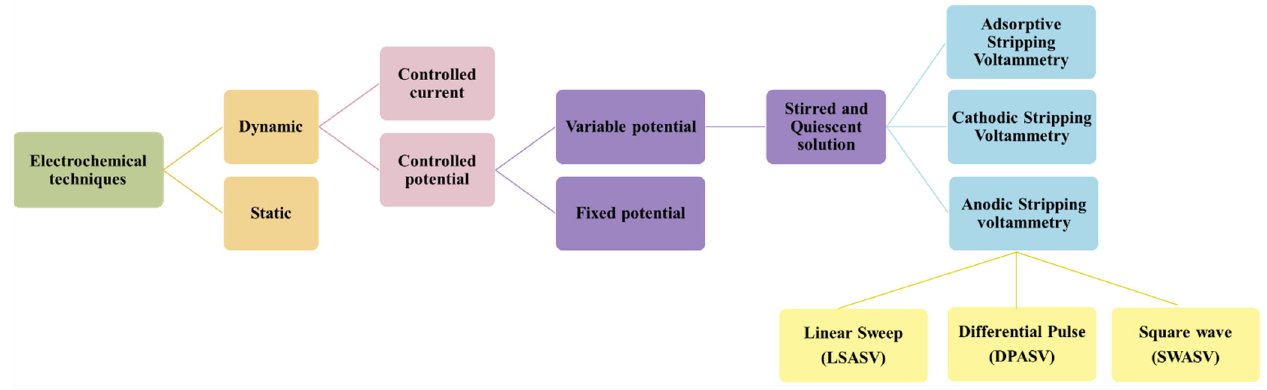
Figure 3. Electrochemical techniques.